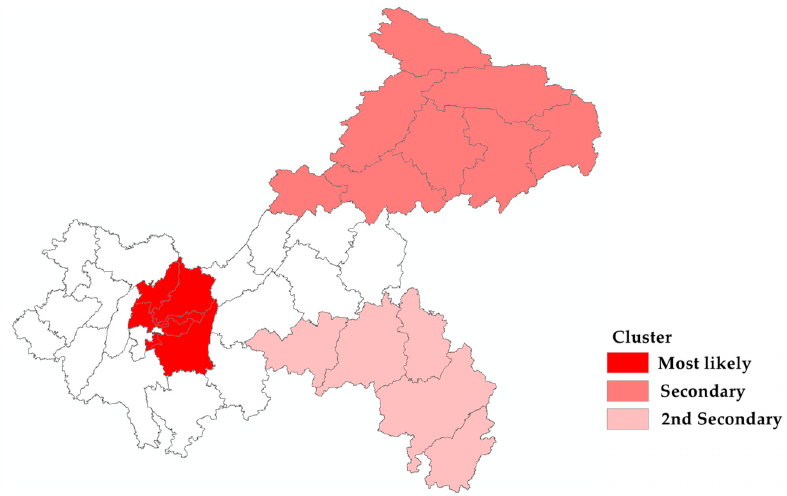
Table 3. Results for spatial clusters of varicella in Chongqing from 2014 to 2018.